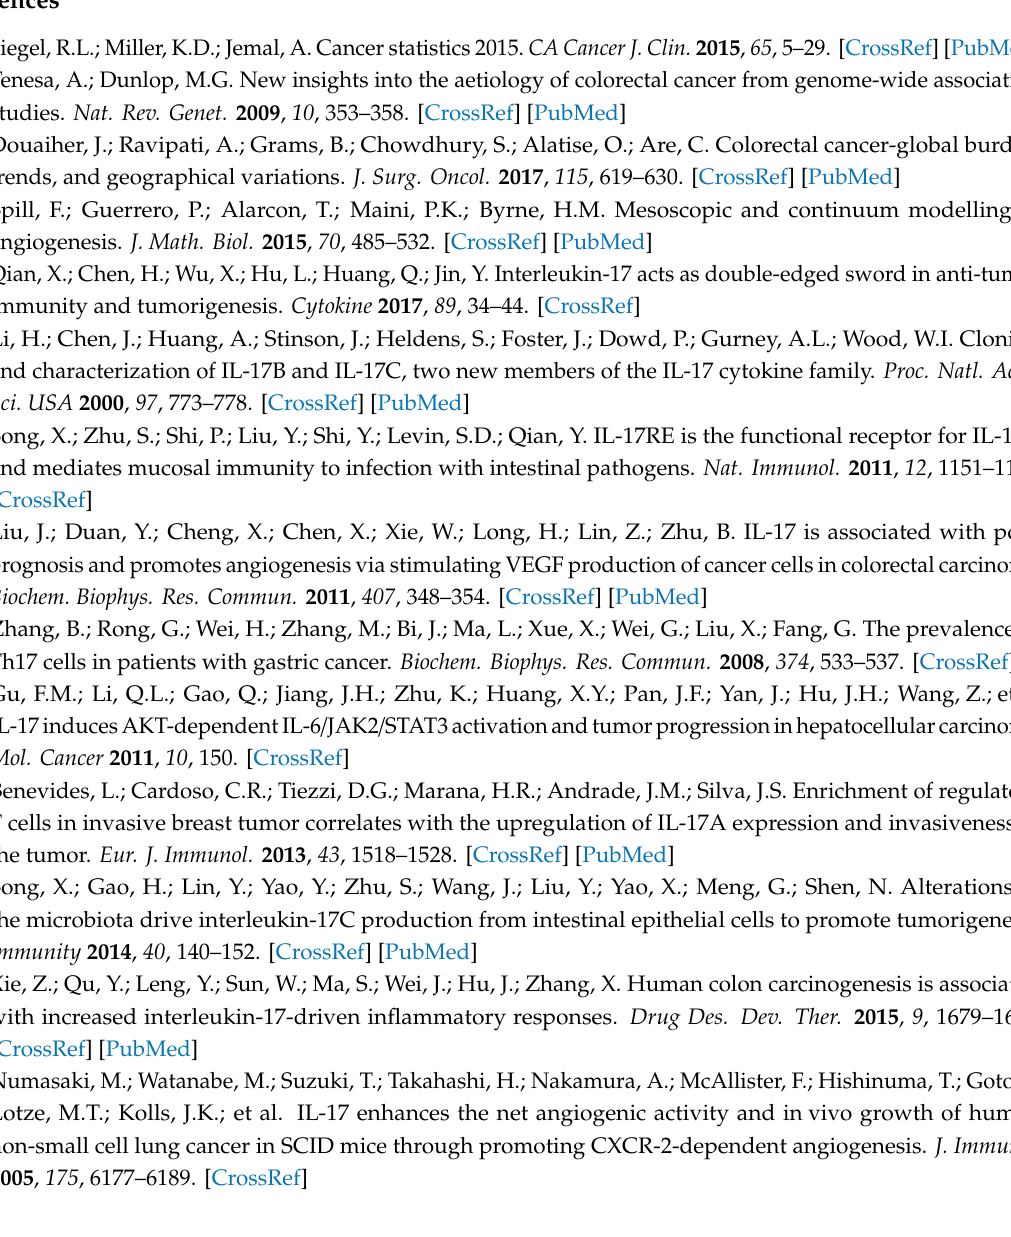
Figure S1: Secretion of other angiogenic-associated cytokines is not significantly changed by IL-17C, Figure S2: Representative bands and two other repeats of RT-PCR of Figure 1A are shown, Figure S3: IHC images of Figure 2A and representative bands and two other repeats of RT-PCR of Figure 2B,C are shown, Figure S4: Representative bands and two other repeats of Western blotting of Figure 5D and representative bands and two other repeats of RT-PCR of Figure 5E are shown, Figure S5: Representative bands and two other repeats of Western blotting of Figure 6A,B,D are